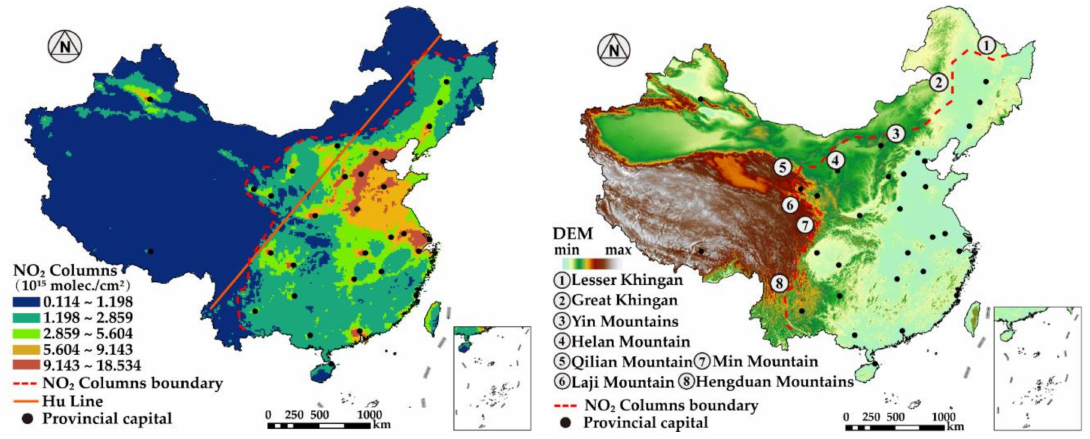
Figure 9. The division line of tropospheric NO 2 column concentration in China.